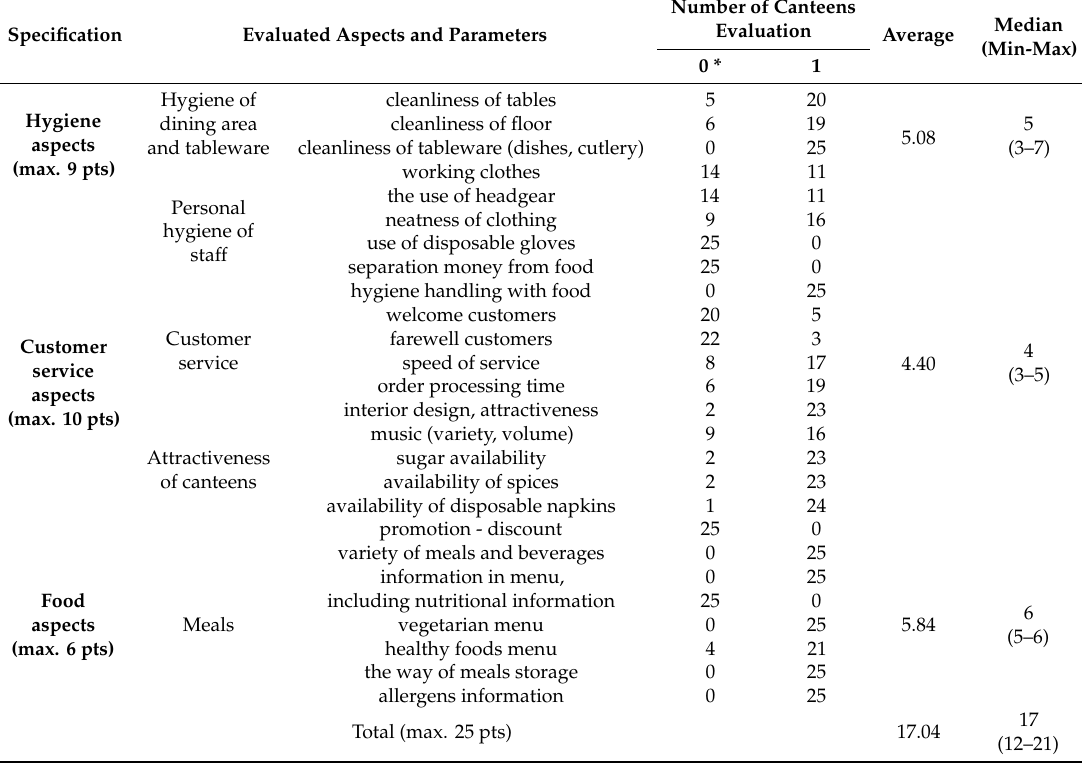
Table 3. Results of inspection (evaluation of canteens) ( n =